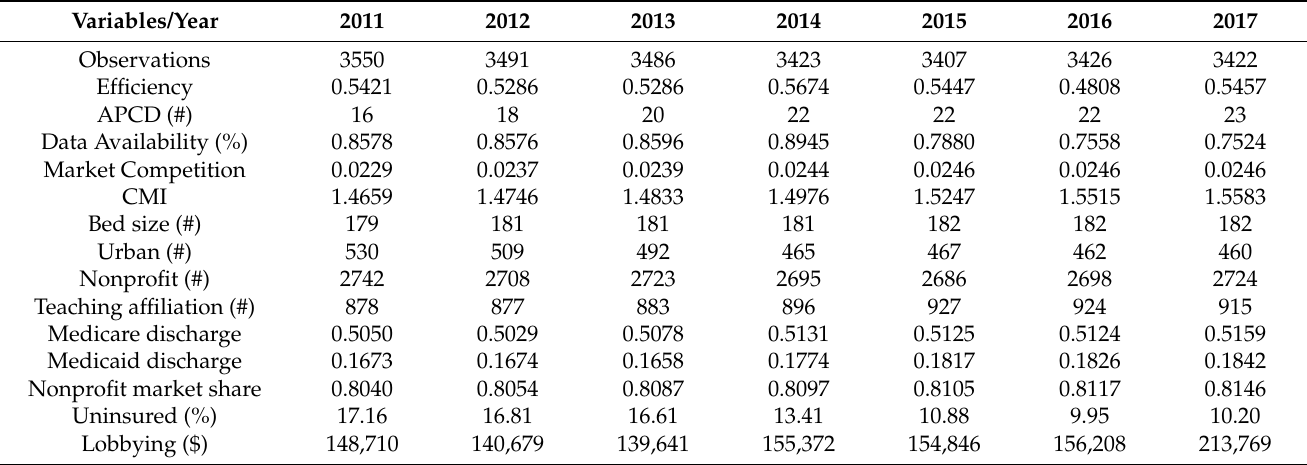
Table 3. Descriptive